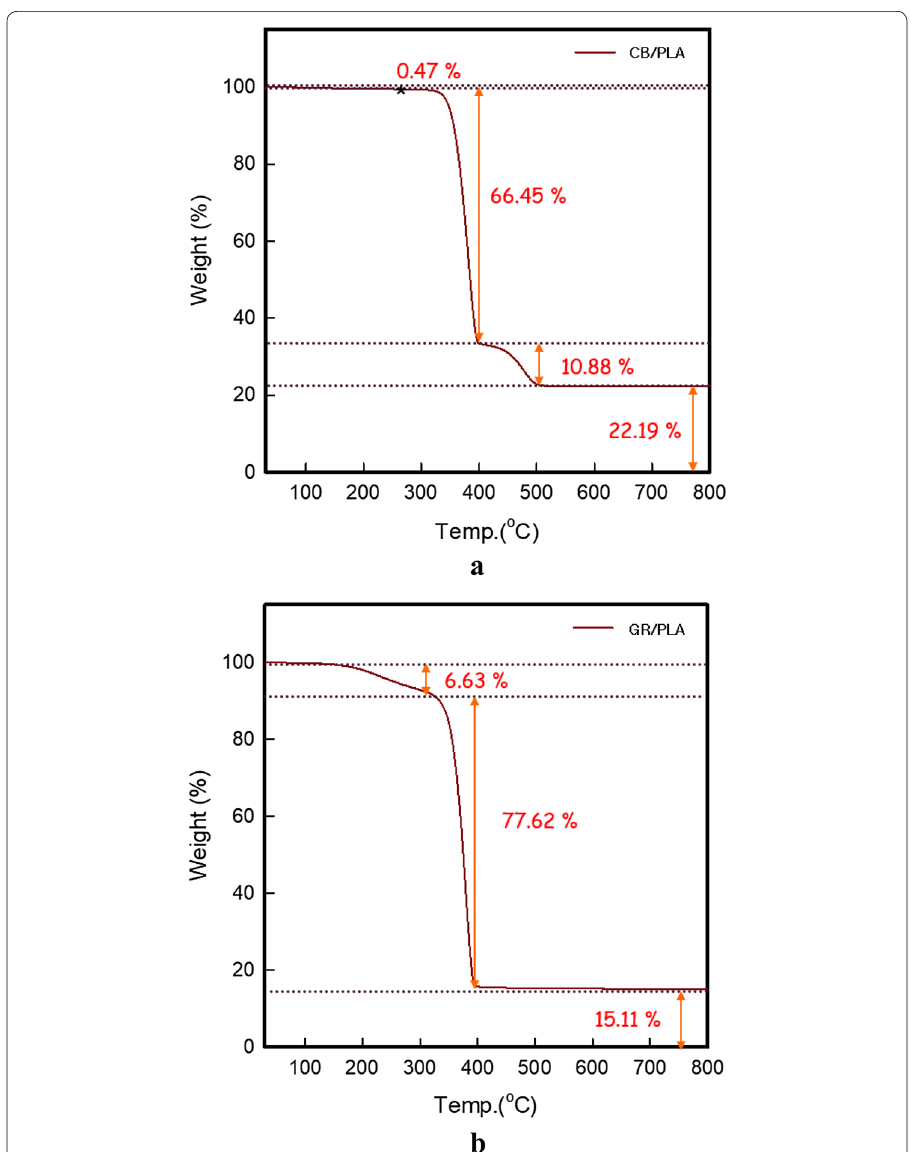
Fig. 3 TGA curves of a carbon black/PLA and b graphene/PLA filament for 3D